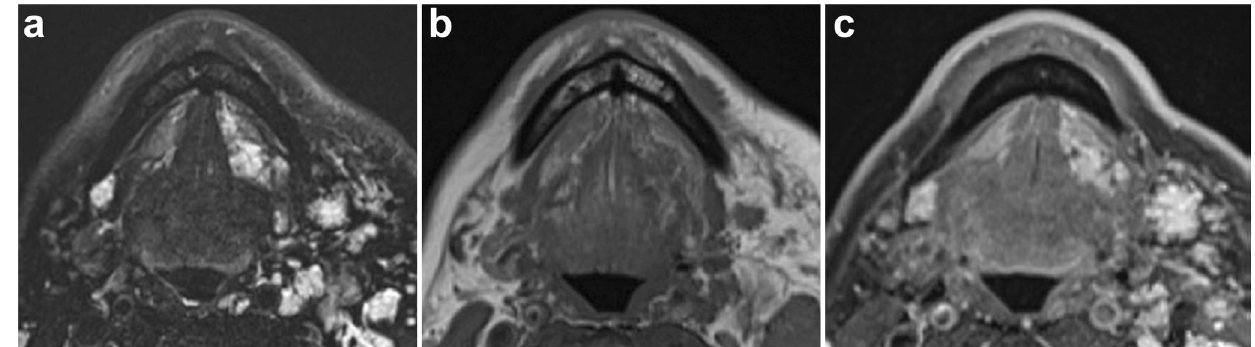
Fig. 12 Mixed veno-lymphatic malformation. a Axial T2-weighted MR image shows multiple trans-spatial high-signal lesions scattered predominantly throughout the left neck spaces, including the left sublingual space. b , c Pre- and post-contrast T1-weighted images show enhancement of these lesions